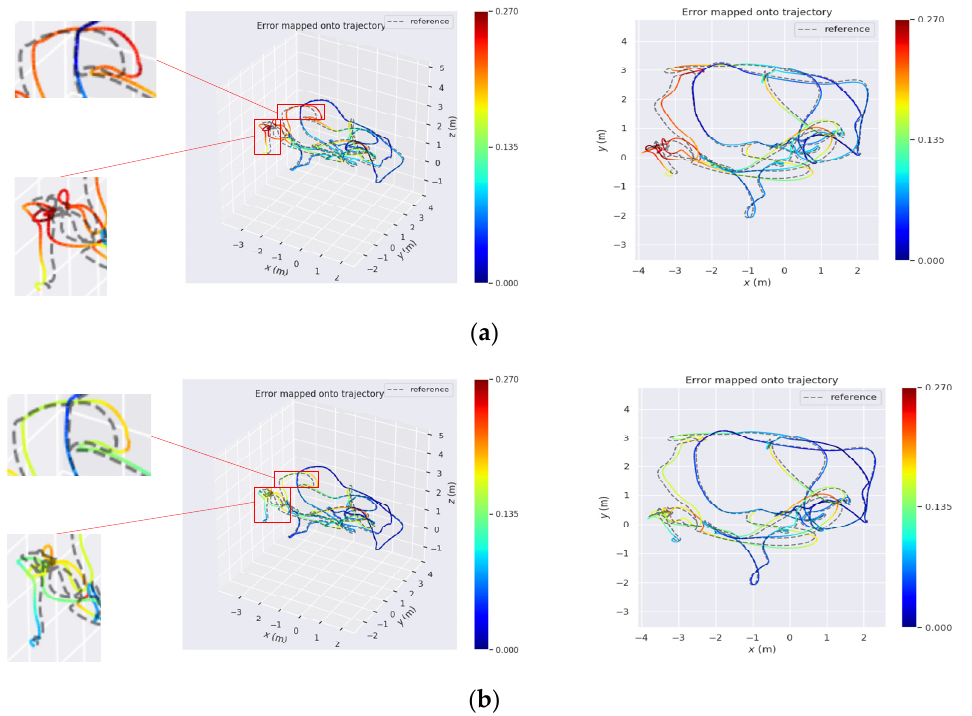
Figure 12. Comparison of trajectory translation errors between IPL–VIO and PL–VIO for the V2_02_medium dataset: ( a ) PL–VIO trajectory error details, overall diagram, and bird’s eye view; ( b ) IPL–VIO trajectory error details, overall diagram, and bird’s eye view.